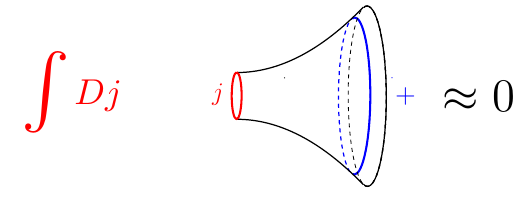
Figure 7: Disappearance of the half-wormhole saddle-point in the